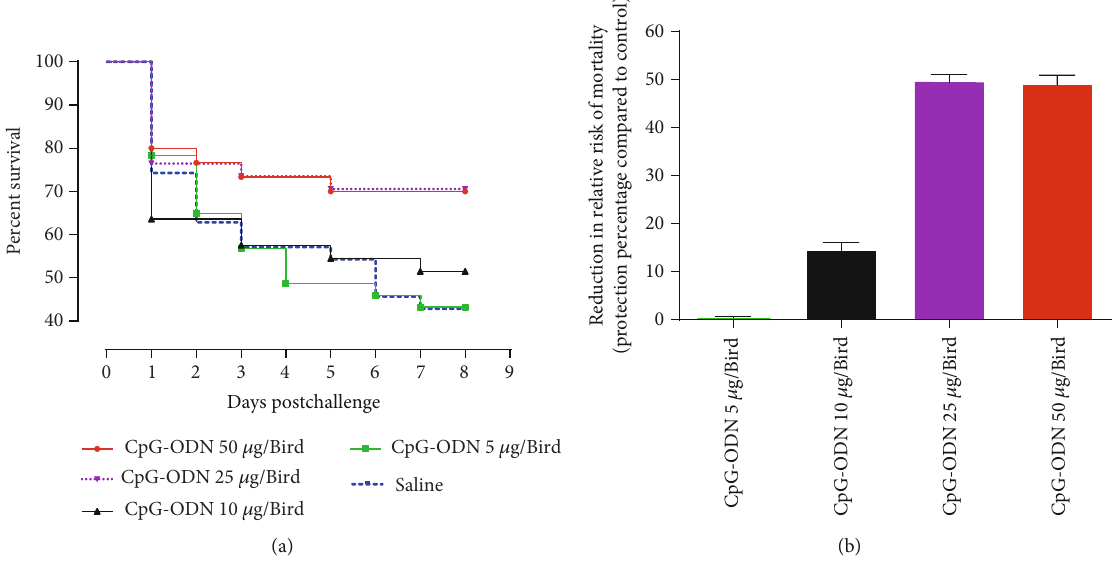
Figure 5: Survival pattern and reduction of the relative risk of mortality following the E.coli challenge. (a) Survival of broiler chickens following E. coli challenge. Groups of broiler chicken embryos at day 18 of incubation were injected with either 5, 10, 25, and 50 μ g of CpG-ODN or sterile saline by the in ovo route and then challenged with either 1 × 10 5 or 1 × 10 4 cfu of E.coli three days later, at the day of hatch . Survival graph was plotted based on the event of a death in birds following challenge for each day postchallenge in each group. Survival was signi fi cantly higher in the birds that received 25 μ g or 50 μ g of CpG-ODN compared to the group of birds that received saline ( P = 0 : 0323 and 0.0430, respectively). (b) The reduction of the relative risk of mortality compared to the saline control group following E. coli challenge.